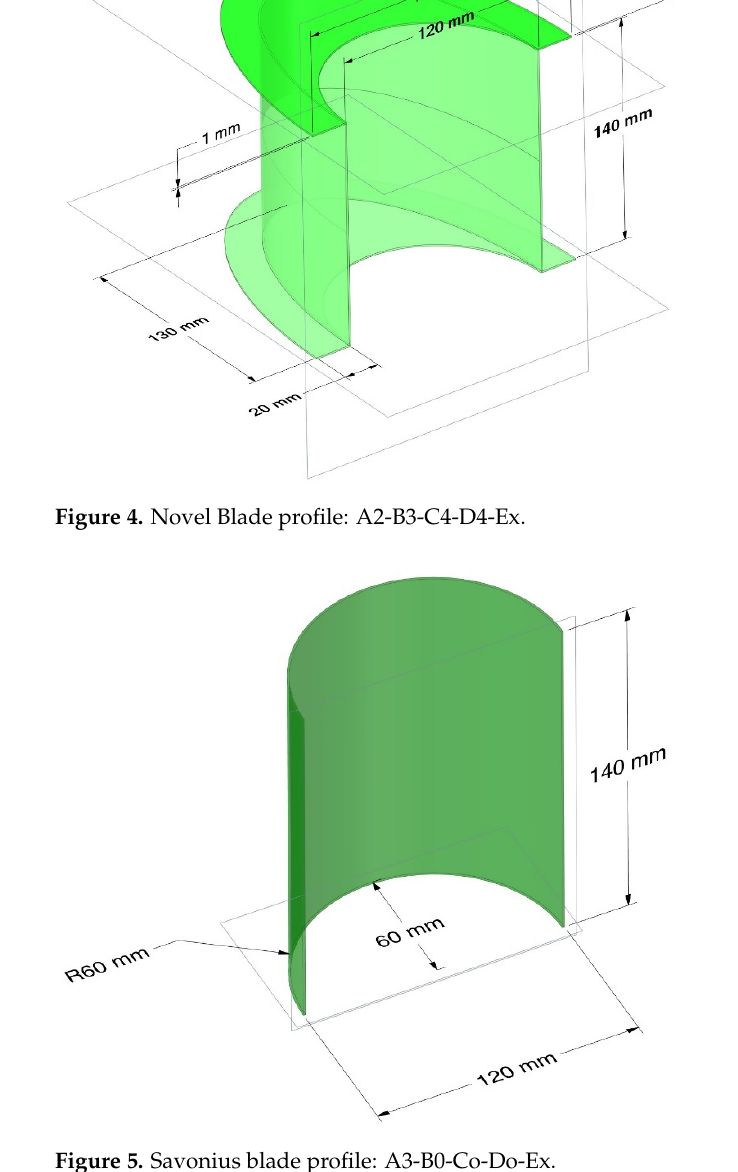
Figure 5. Savonius blade profile: A3-B0-Co-Do-Ex.